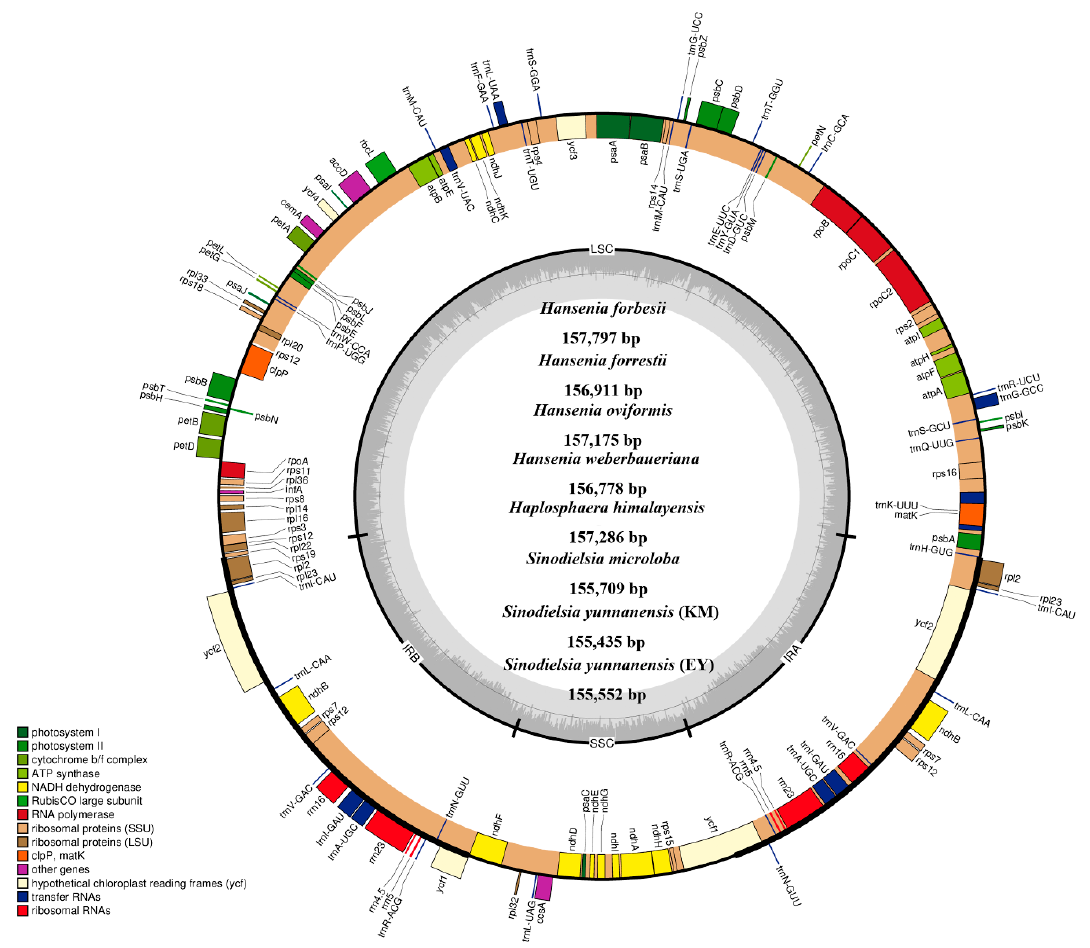
Figure 3. Plastid genome map of eight Hansenia , Haplosphaera and Sinodielsia species (for a better view, these eight maps were combined into one derived from the map of H. forbesii because they have the same order and composition of genes). The genes shown inside and outside of the circle indicate those transcribed in the clockwise and counterclockwise direction, respectively. Genes of different functional groups are colored differently. The GC contents are shown in the inner circle with darker grey.